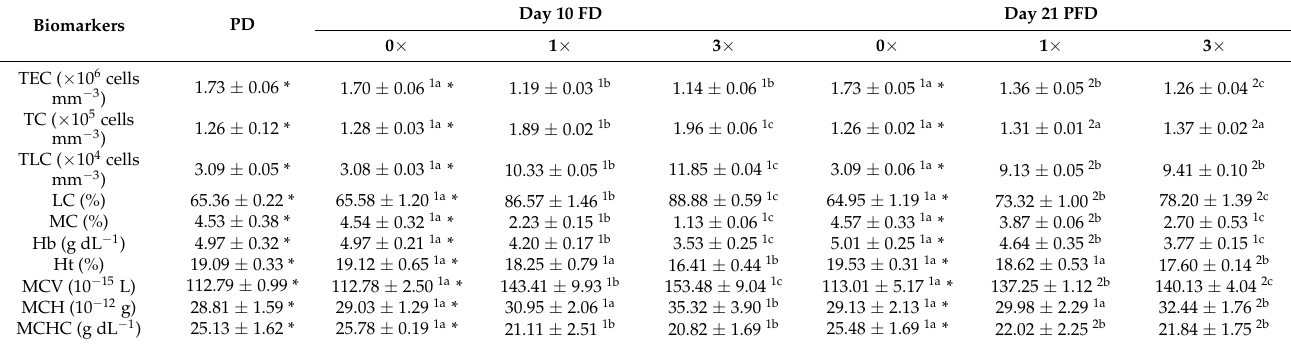
Figure 3. Effectsofflorfenicol(FFC)dosingat0–3timesthetherapeuticdoseof15 mg kg biomass − 1 day − 1 for 10 consecutive days on the serum ( A ) alkaline phosphatase (ALP), ( B ) alanine transaminase (ALT), ( C ) aspartate transaminase (AST), and ( D ) creatinine levels of Oreochromis niloticus juveniles. a–c: bars sharing a common alphabet for a particular day differed insignificantly ( p > 0.05). 1–5: bars sharing a common numerical for a particular treatment (dose) differed insignificantly ( p > 0.05). Table 3. Details of the hematological biomarkers tested and the kits used to assess the effect of dietary florfenicol in Oreochromis niloticus